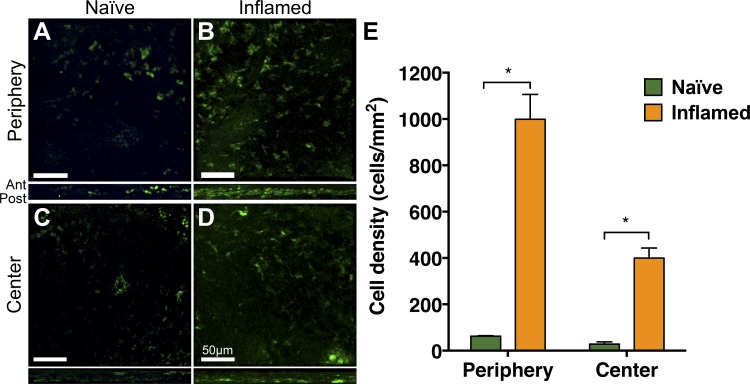
Inflammation leads to increased recruitment of adoptively transferred cDCs into the cornea. Representative confocal micrographs of the peripheral (A, B) and central (C, D) corneas and respective orthogonal views, highlighting distribution of recruited cDCs throughout the cornea of naïve (A, C) and suture inflamed (B, D) BALB/c corneas 24 hours following intravenous adoptive transfer of fluorescently labeled cDCs (green). (E) Cell density quantification of recruited cDCs into the corneal stroma (density cells/mm2). Scale bars denote 50 μm. Data are shown as mean ± SEM. *P < 0.05. n = 4/group.